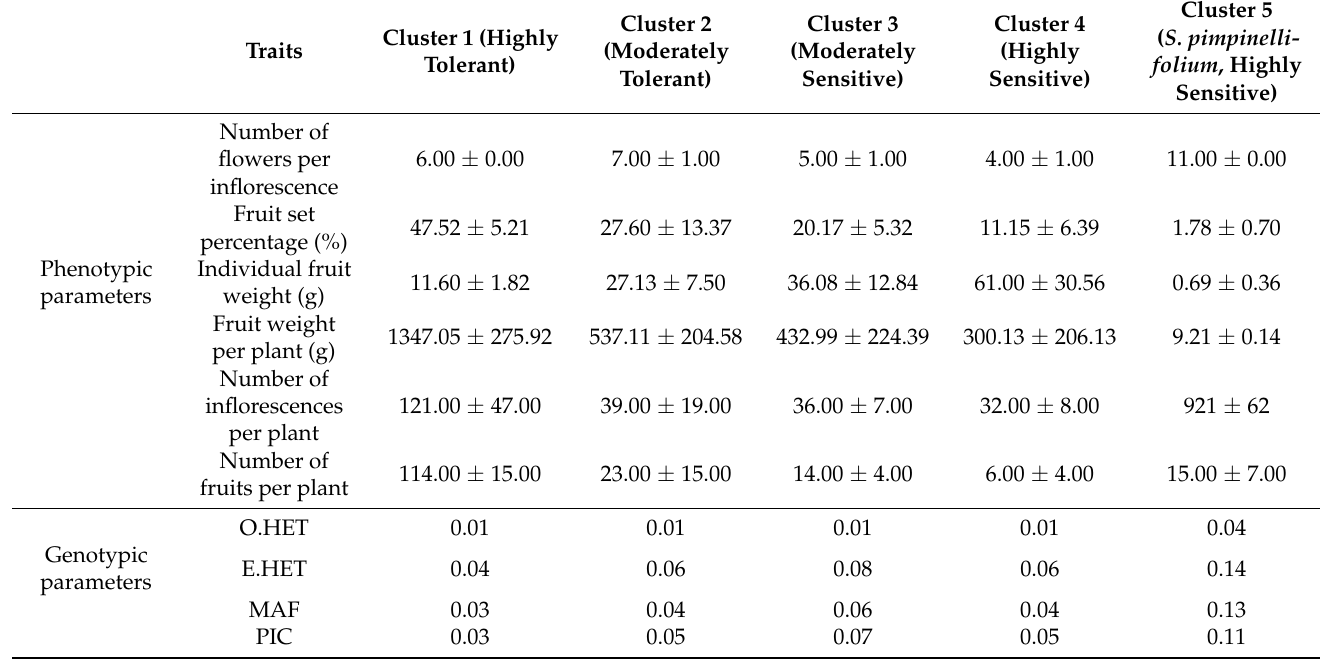
Table 4. Characteristics of the clusters formed based on combined genomic and phenotypic datasets.